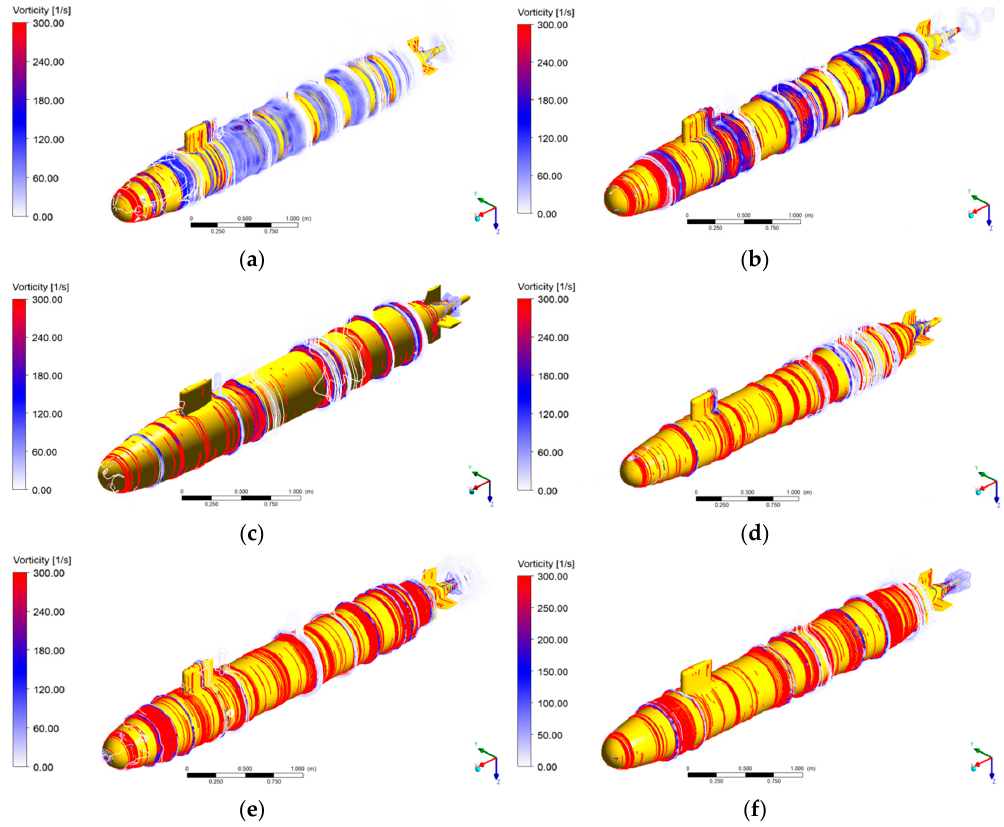
Figure 7. The vorticity distribution around the SUBOFF model under towing speeds of ( a ) 3.05 m/s;